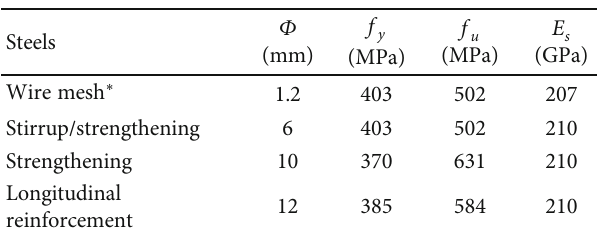
Table 1: Properties of steels.